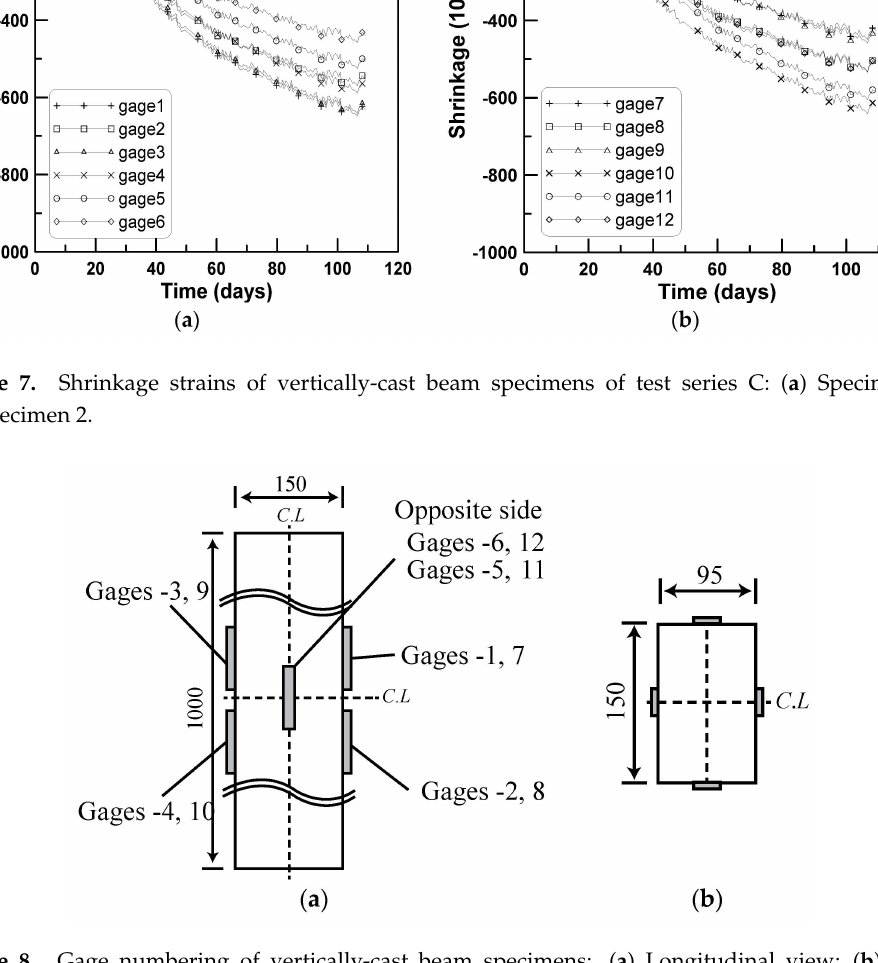
Figure 8. Gage numbering of vertically-cast beam specimens: ( a ) Longitudinal view; ( b ) cross sectional view.